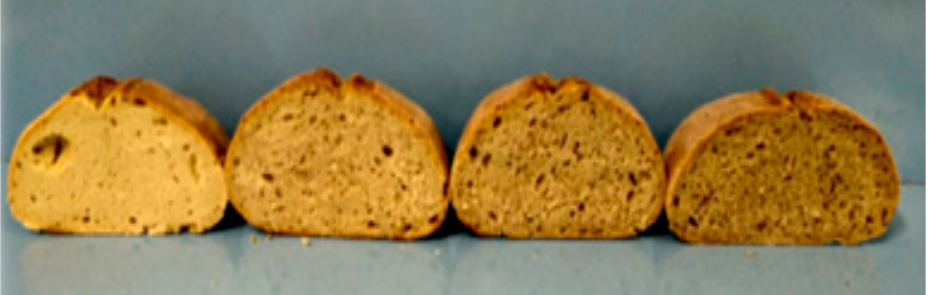
Figure 2. Results of sensory evaluation of breads with addition of Norik black oat wholemeal fl our (sum of all panellists). C—control bread; H3—bread with 3% Hucul addition; H6—bread with 6% Hucul addition; H9—bread with 9% Hucul addition; N3—bread with 3% Norik addition; N6—bread with 6% Norik addition; n.d.—not detected; N9—bread with 9% Norik addition.